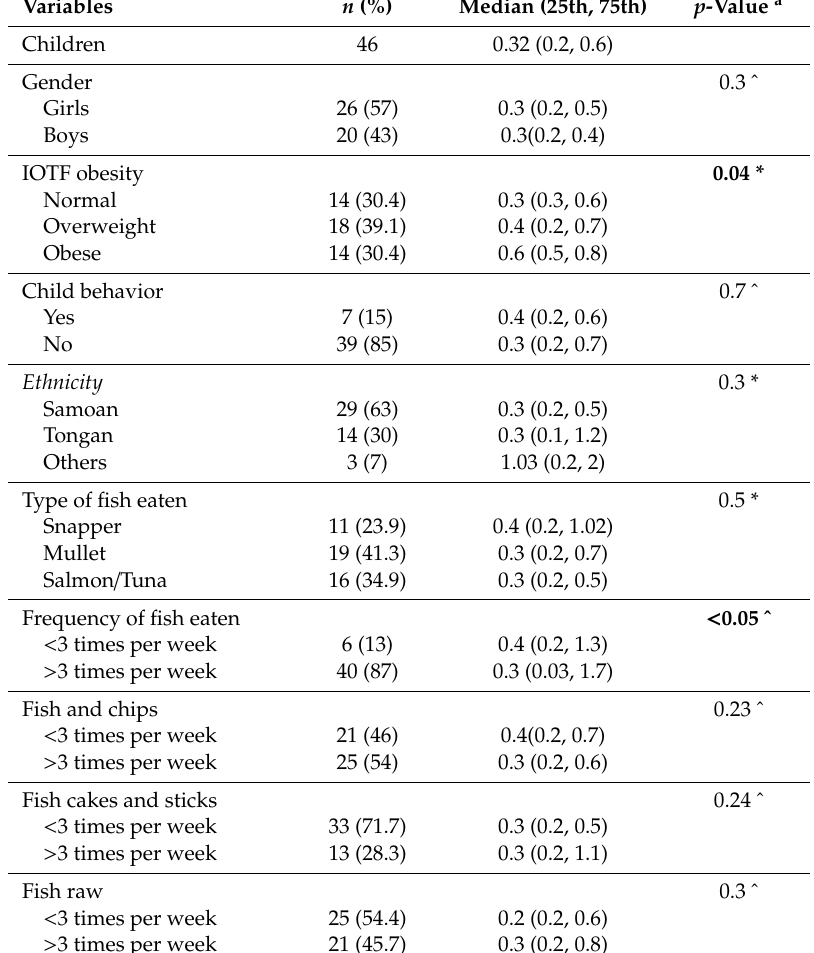
Table 2. The median, 25th, and 75th percentiles of total mercury concentrations ( µ g / g Hg) in Pacific Island children’s hair